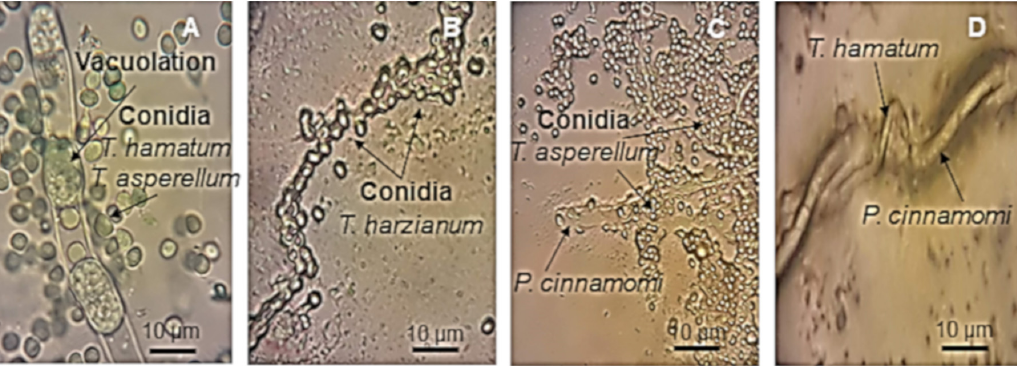
Figure 5. Hyphal interactions and mycoparasitism of indigenous species of Trichoderma spp. observed at 100× magnification. ( A ) Vacuolation of Phytophthora cinnamomi strain CPO-CPU induced by Trichoderma hamatum and T. asperellum . ( B ) Conidia of T. harzianum surrounding and lysing the mycelium of the pathogen. ( C ) Conidia of T. harzianum and T. asperellum surrounding the mycelium of P. cinnamomi . ( D ) Abnormal mycelium and massive hyphal curl of T. hamatum and T. koningiopsis covering the pathogen P. cinnamomi